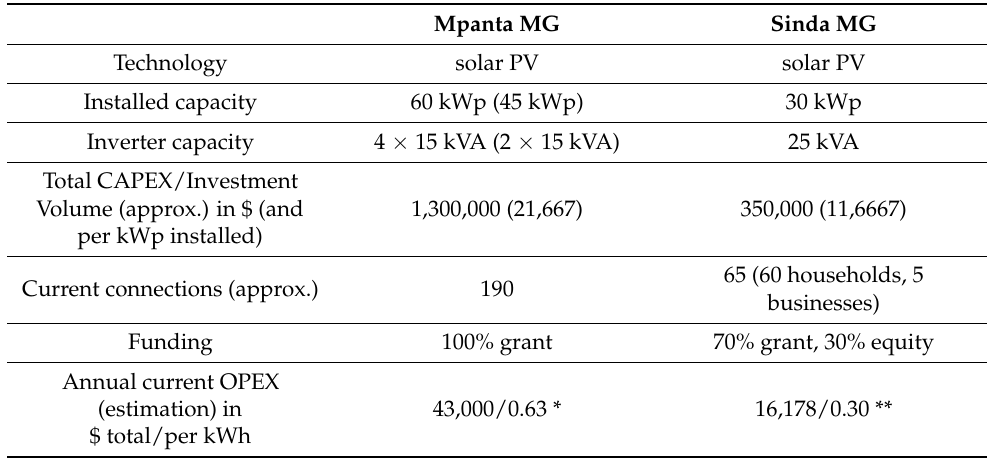
Table 3. Overview technical and financial specifications for Mpanta and Sinda